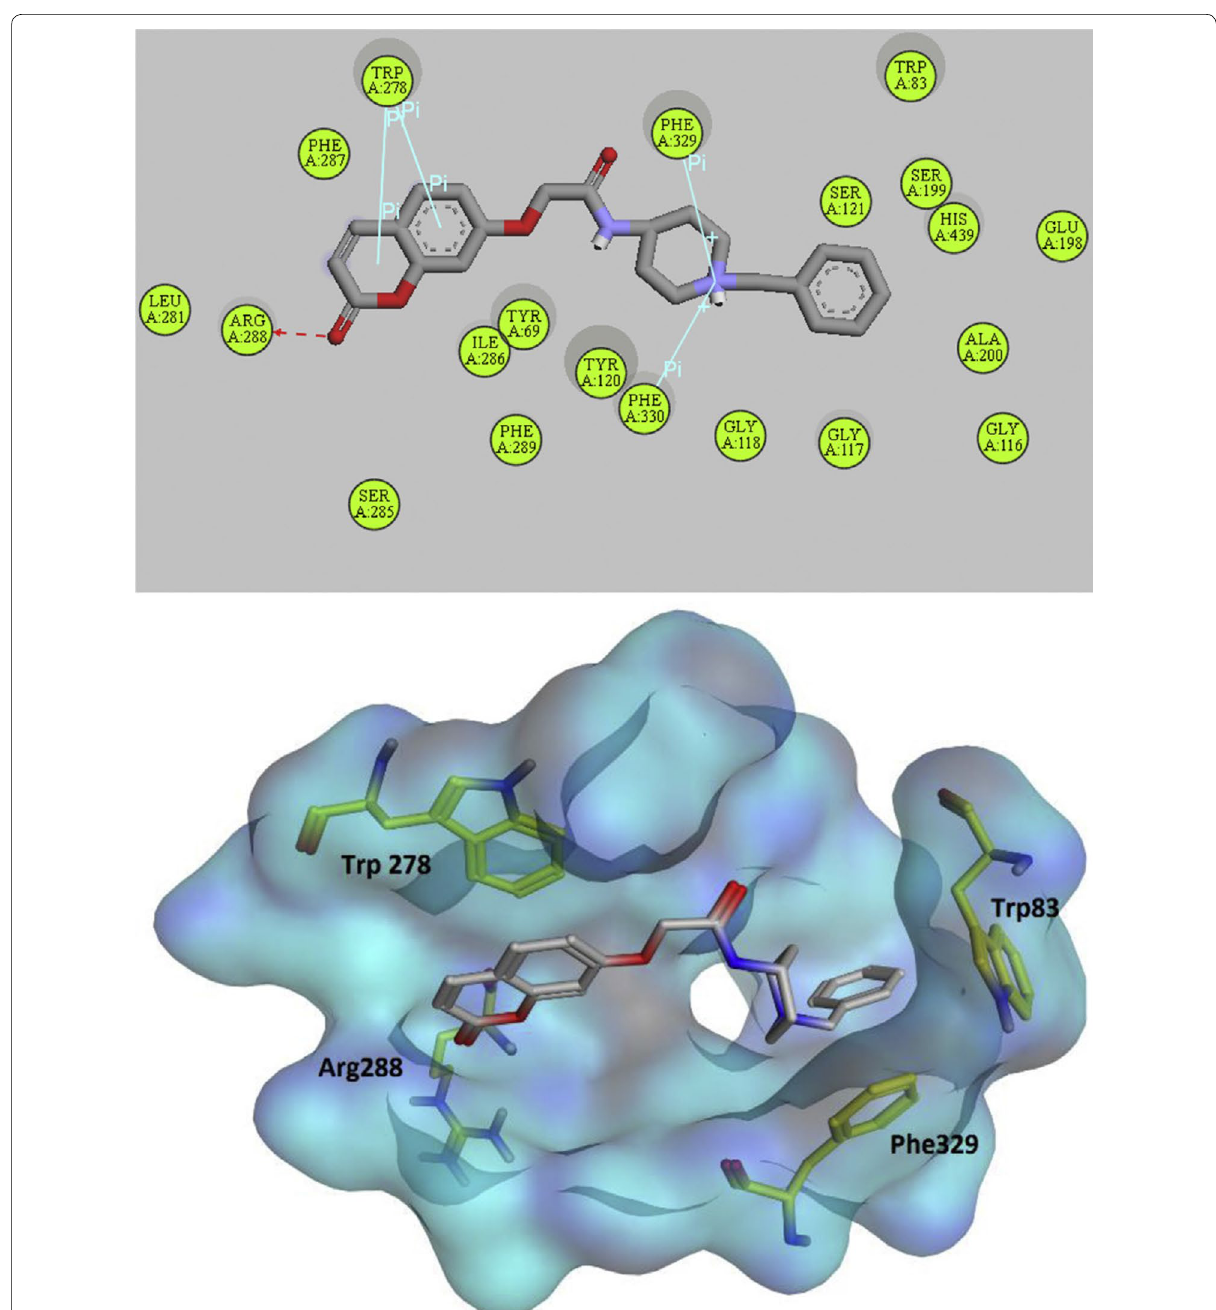
Fig. 27 The schematic 2D and 3D representations of compound C18 , docked in the active site of AChE